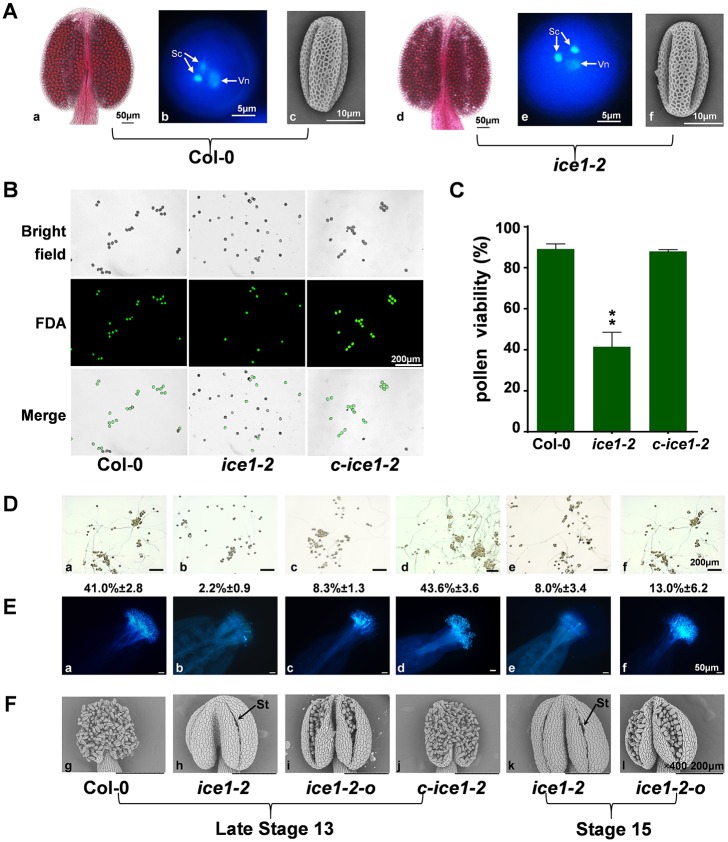
Pollen phenotypes, viability and germination analysis in ice1-2.(A) Alexander staining of the anther, DAPI staining of pollen at tricellular stage, scanning electron microscopy (SEM) of pollen grains from Col-0 and ice1-2. Vn, vegetative nuclei; Sc, sperm cells. (B) FDA (fluorescein diacetate) staining of pollen from Col-0, ice1-2 and c-ice1-2 at flower stage 13. (C) Comparison of viability of pollen from Col-0, ice1-2 and c-ice1-2. SE, n = 5, ** p < 0.01. (D) The in vitro germination of pollen from Col-0, c-ice1-2, ice1-2 and selected ice1-2 anthers with obviously open and enlarged stomium (ice1-2-o) at flower stages indicated. The germination rates are listed below photographs. SE, n = 3. (E) Aniline blue-stained pistils of Col-0 flowers at 2 h after pollination with pollen from Col-0, c-ice1-2, ice1-2 and ice1-2-o at flower stages indicated. (F) Scanning electron micrographs of the anther adaxial surface from Col-0, c-ice1-2, ice1-2 and ice1-2-o at flower stages indicated. Arrows indicate the stomium in the ice1-2 anther. St, stomium.